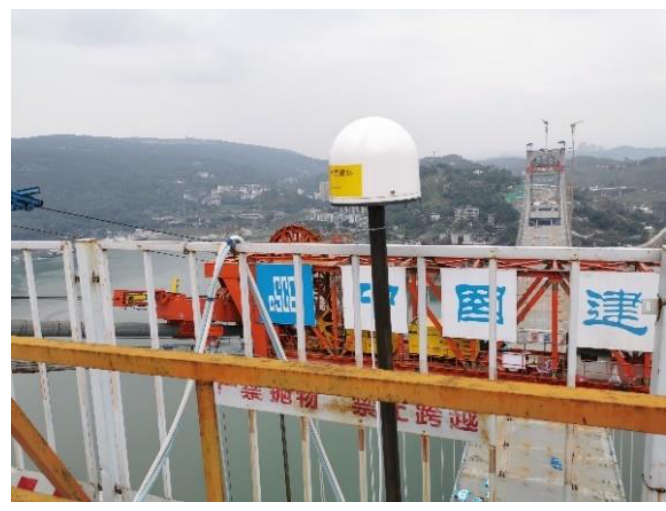
Figure 13. GNSS monitoring station QNT1.